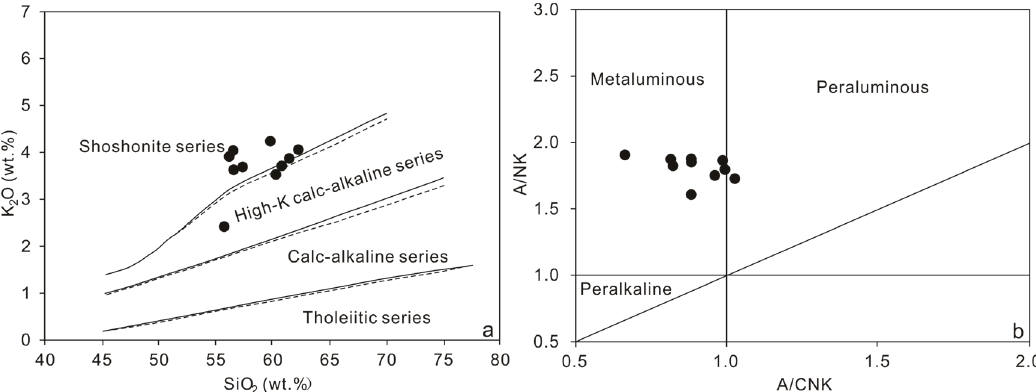
Figure 7. ( a ) K 2 O versus SiO 2 plot for classification of rocks from the No. 3 granodiorite; ( b ) A/NK versus A/CNK diagram shows that the No. 3 granodiorite has a metaluminous geochemical affinity.